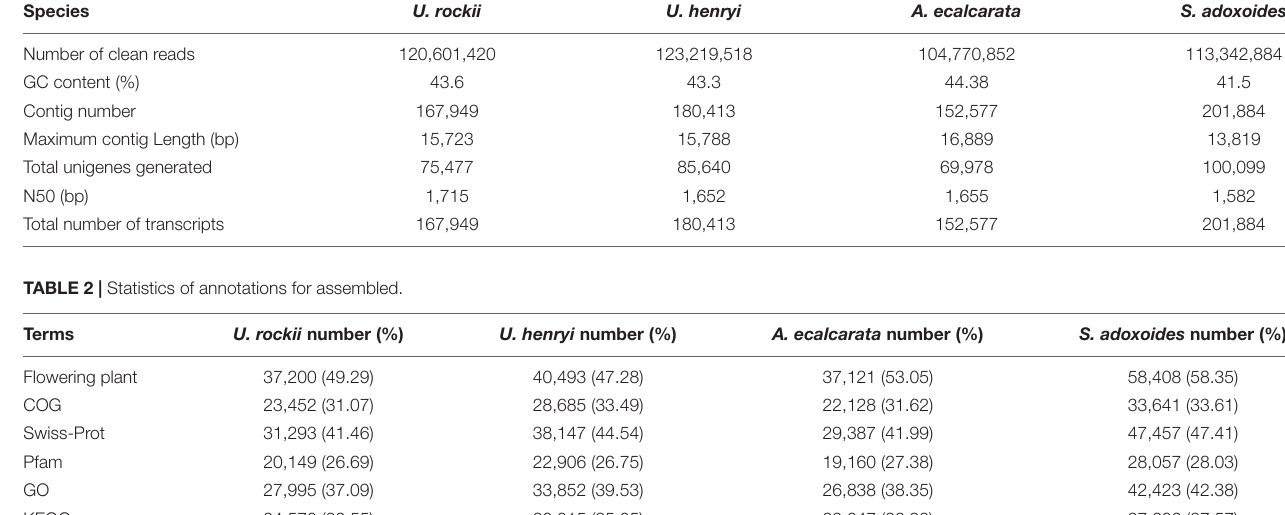
TABLE 1 | Overview of the de novo assembly of the transcriptome of all species. Species